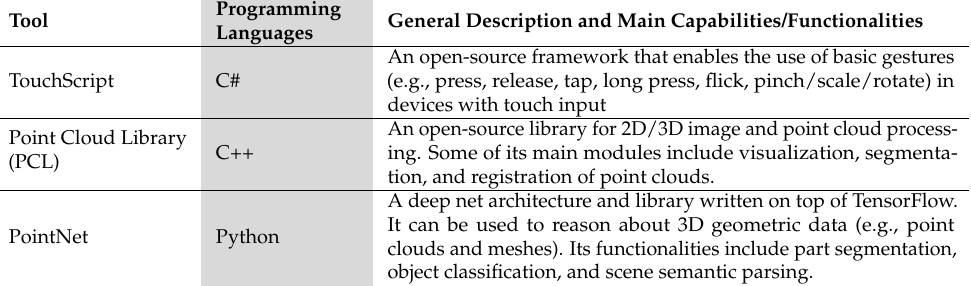
Table 4. Specifications and capabilities of identified interaction tools in the reviewed